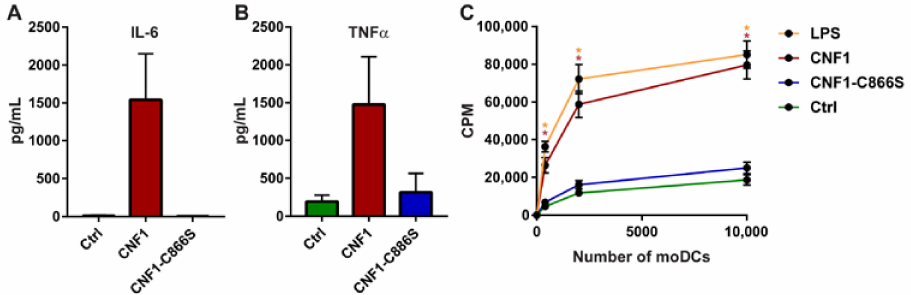
Figure 4. CNF1 induces functional maturation of moDCs. ( A , B ) Immature moDCs were cultured for 24 h without toxin (Ctrl), with 0.1 nM CNF1 or with 0.1 nM CNF1-C866S before the concentrations of ( A ) interleukin-6 (IL-6) and ( B ) TNF α in the cell culture supernatants were determined by enzyme-linked immunosorbent assay (ELISA). ( A , B ) Shown is the mean cytokine concentration + SEM in cell culture supernatants from 3 independent experiments each using moDCs derived from different donors ( n = 3). ( C ) Immature moDCs were cultured for 48 h with 0.1 nM CNF1, 0.1 nM CNF1-C866S, 50 ng/mL LPS or without toxin (Ctrl). The moDCs were subsequently washed and different numbers cultured with allogenic naïve CD4+ T cells for 4 days. Then [ 3 H]-thymidine was added, and the cells cultured for 24 h further, before determination of [ 3 H]-thymidine incorporation. Shown are the mean counts per minute (CPM) from 3 independent experiments. Each independent experiment was performed using moDCs and allogenic naïve CD4+ T cells derived from different donors (total of 6 donors). Error bars represent SEM and * denotes a significant difference ( p < 0.05) compared to CD4+ T cells cultured with the same number of Ctrl moDCs using a two-way ANOVA with Sidak’s multiple comparisons